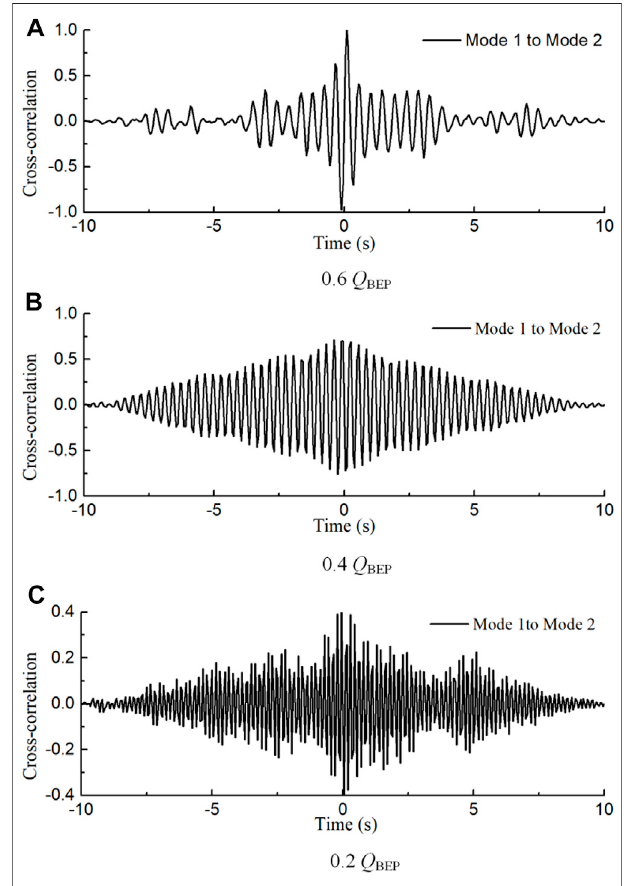
FIGURE 9 | Cross-correlation between the fi rst mode and the second mode. (A) 0.6 Q BEP , (B) 0.4 Q BEP , (C) 0.2 Q